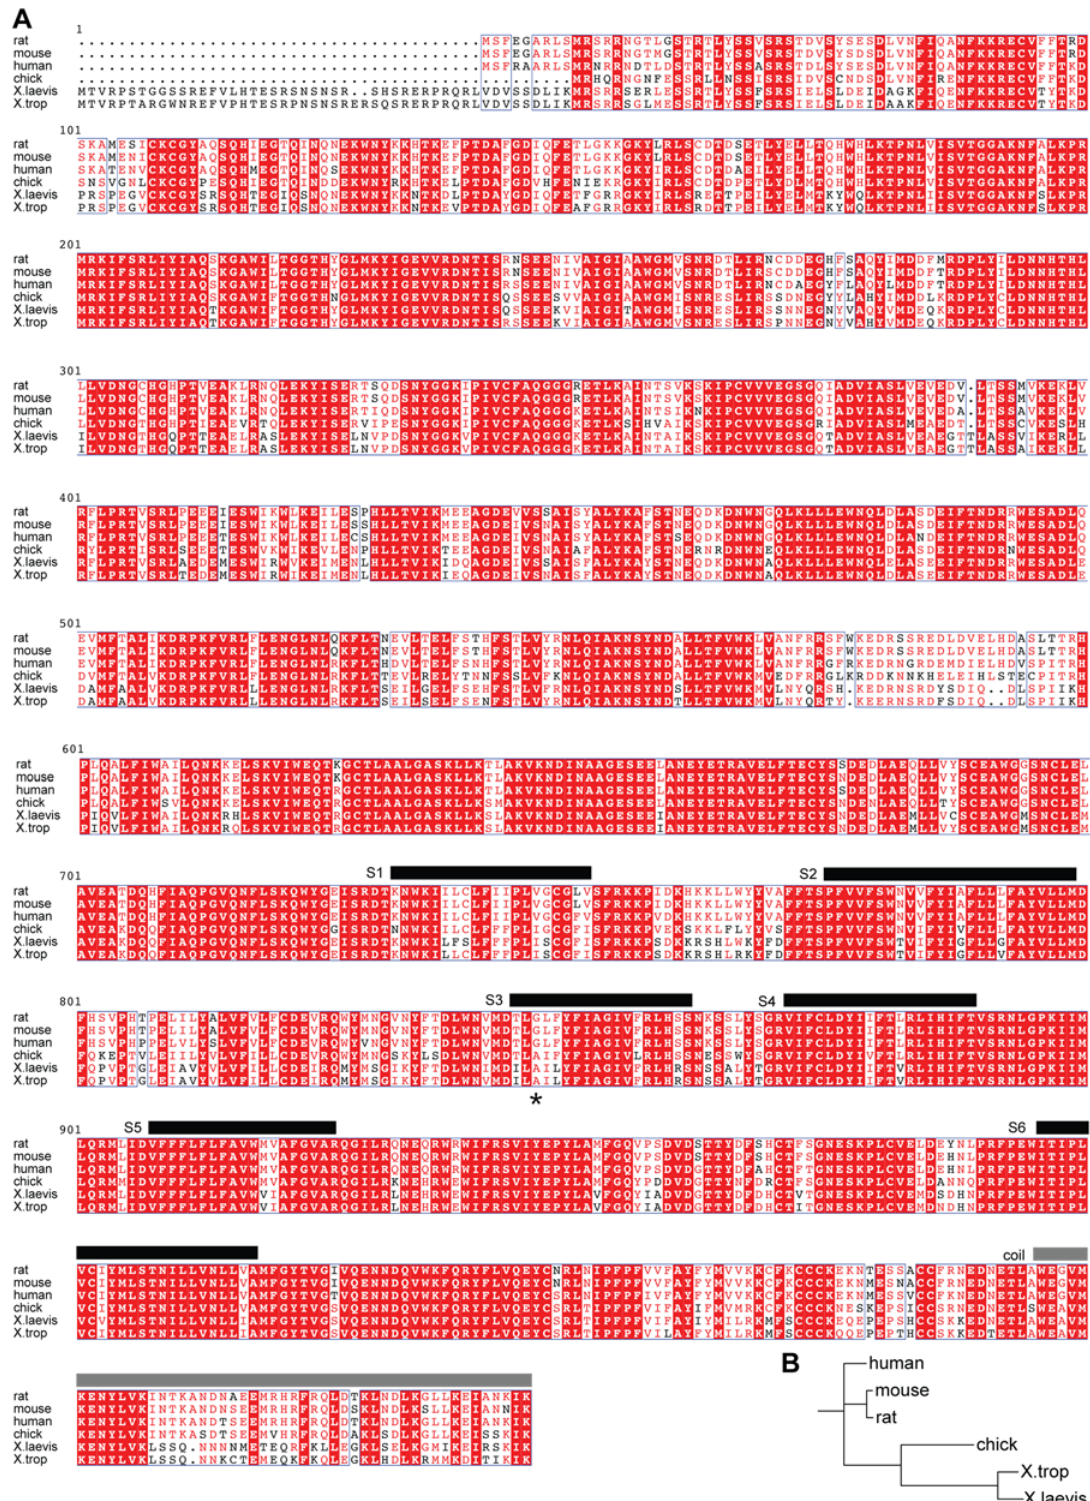
Figure 2. Sequence comparison of TRPM8 species orthologs. ( A ) Previously described rat, human, and chicken TRPM8 sequences were aligned with the full-length sequences of X. tropicalis and X. laevis TRPM8 (this study) using MultAlin and ESPript. The locations of predicted transmembrane helices [6] and the C-terminal coiled-coiled assembly domain [25] are shown as black and gray bars, respectively. The asterisk indicates the polymorphic residue previously shown to determine TRPM8 icilin sensitivity [17]. ( B ) Phylogenetic tree indicating the evolutionary relationship between TRPM8 ortholog sequences.